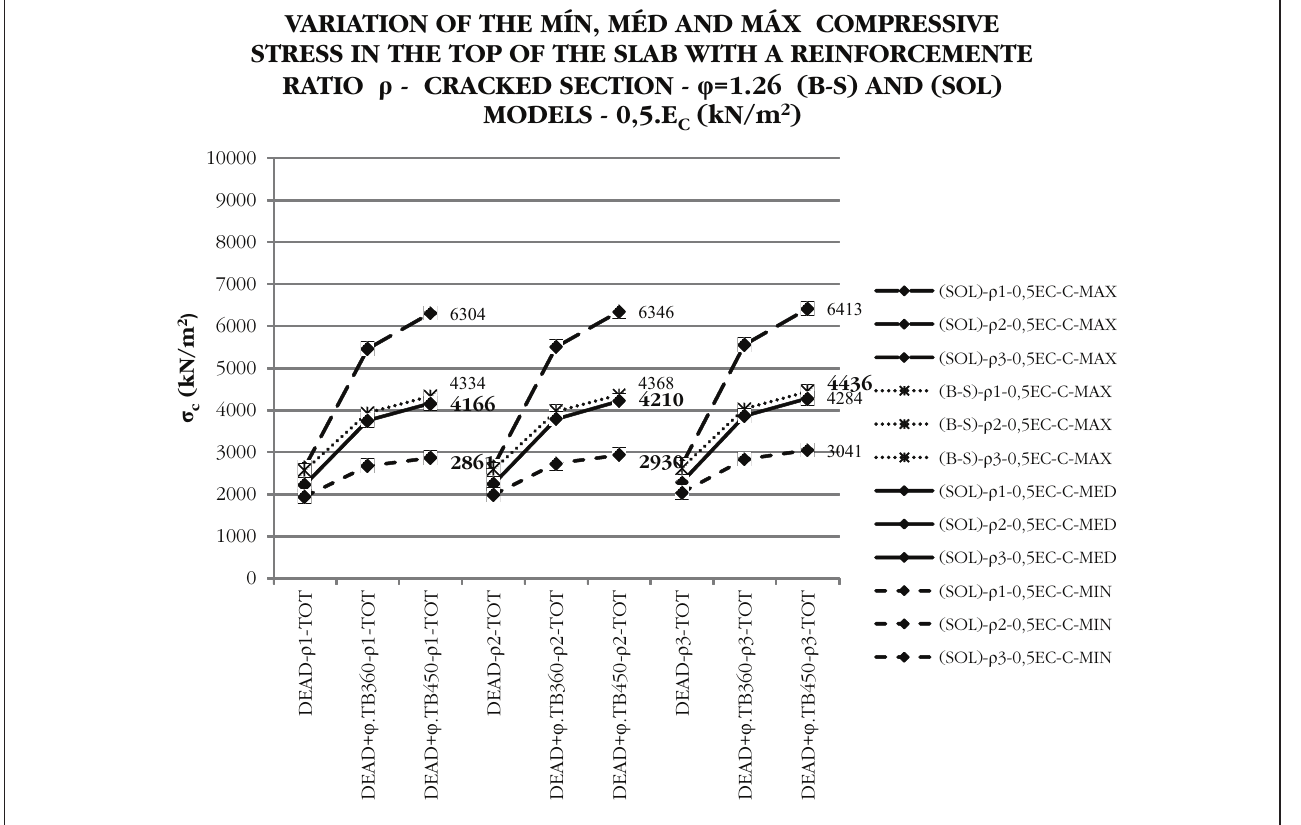
Figure 18 – Variation of minimum, medium and maximum longitudinal compressive stress in the top of the slab versus ρ for (B-S) and (SOL) models, in cracked section, modulus of elasticity 0.5.E , with impact, caused by {DEAD}, {DEAD + φ .TB360} and {DEAD + φ